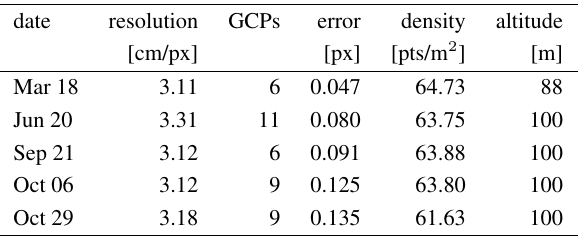
Table 1: Properties of sUAS surveys performed in the year 2015: date, ground resolution of the photos, number of GCPs, GCPs error, point densities and flight altitude. All surveys were flown after significant rainfall period, except for Sep